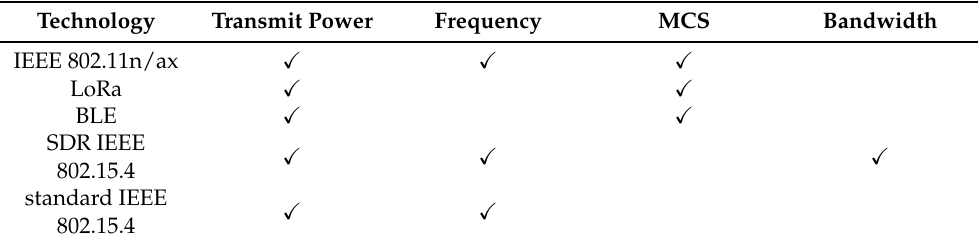
Table 2. Reconfigurable physical (PHY) layer parameters for different technologies.